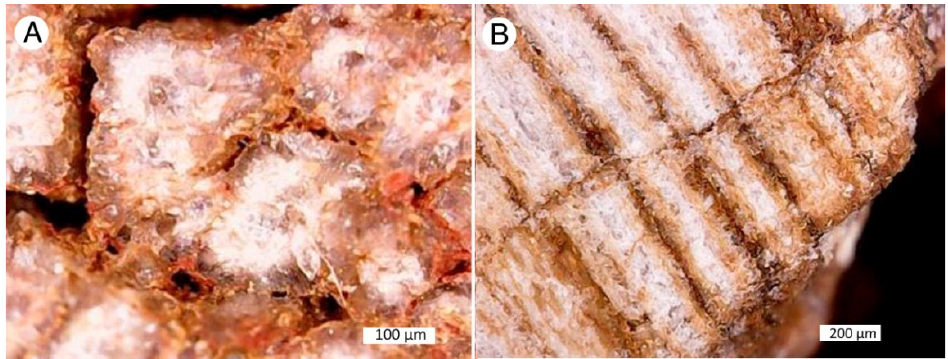
Figure 20. Iron oxide stains are concentrated where Fe-bearing solutions entered intercellular spaces between fiber cells and parenchyma tissue surrounding vessels. ( A ) Transverse view. ( B ) Longitudinal view.